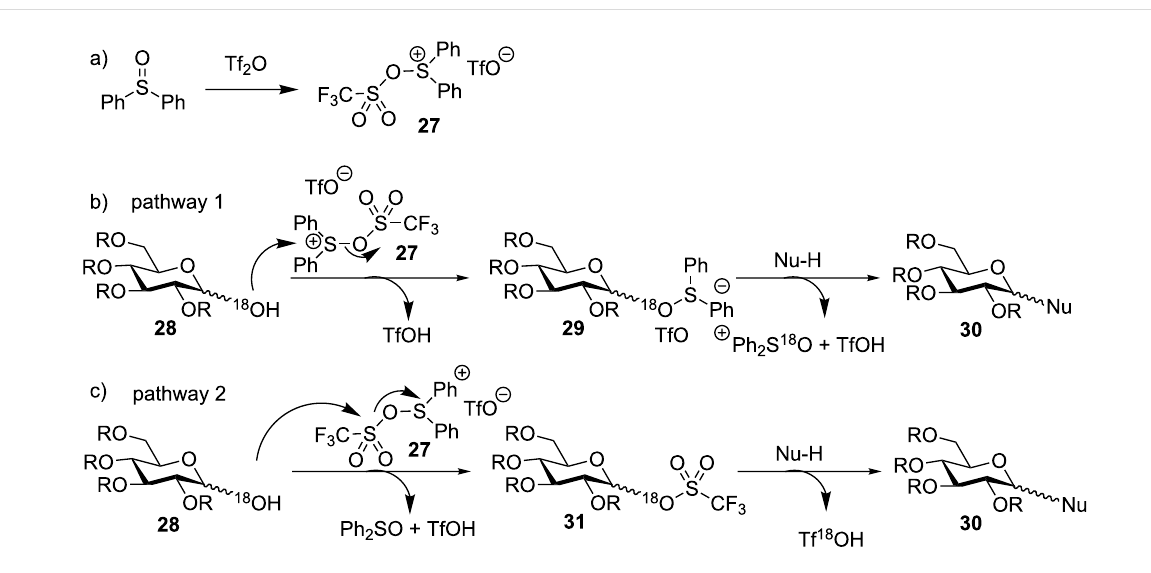
Scheme 7: Possible mechanism for the dehydrative glycosylation. (a) Formation of diphenyl sulfide bis(triflate) ( 27 ) as the promoter for glycosyl hemi- acetal activation; (b) pathway 1 and (c) pathway 2 as potential mechanisms for glycosyl hemiacetal activation.